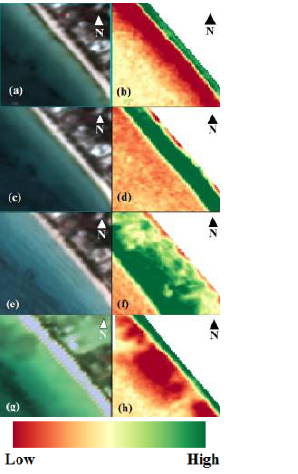
Figure 8: True Color and Normalized Difference Vegetation Index (NDVI) Image for (a & b) April 25 (c & d) May 18 (e & f) July 2 (g & h) October 7. Figure (a) showed the zoomed in area of the selected pixel in the FAI values of April 25 using KOMPSAT-3A. It can be